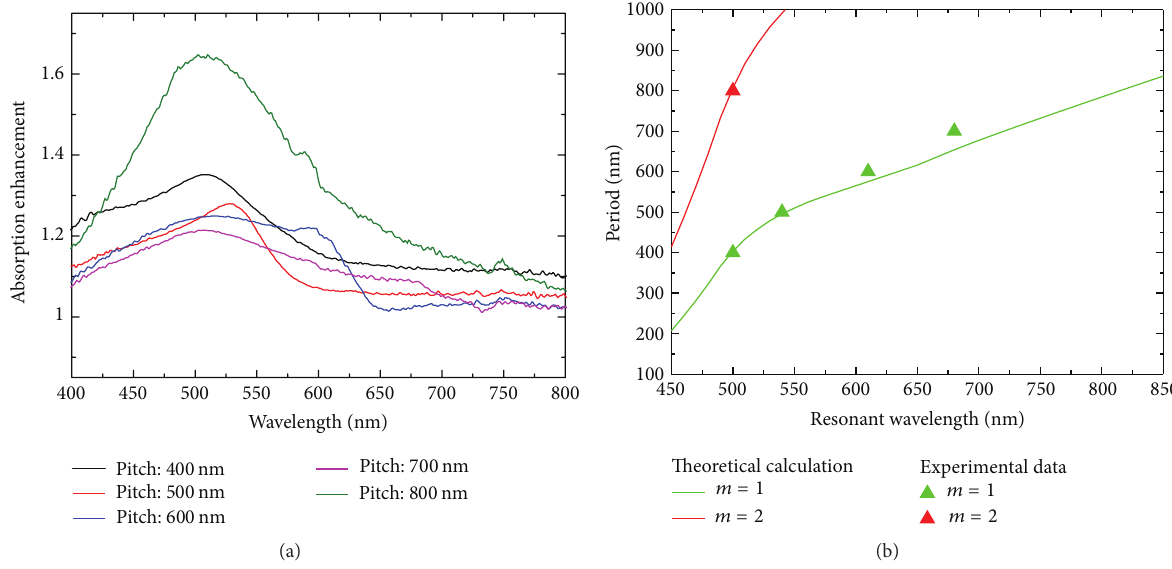
Figure 4: (a) Comparison of enhanced absorption in terms of different pitch size Au concentric circular grating. (b) Experimental and as a function of pitch. theoretical (2) SP resonant wavelengths 𝜆 sp